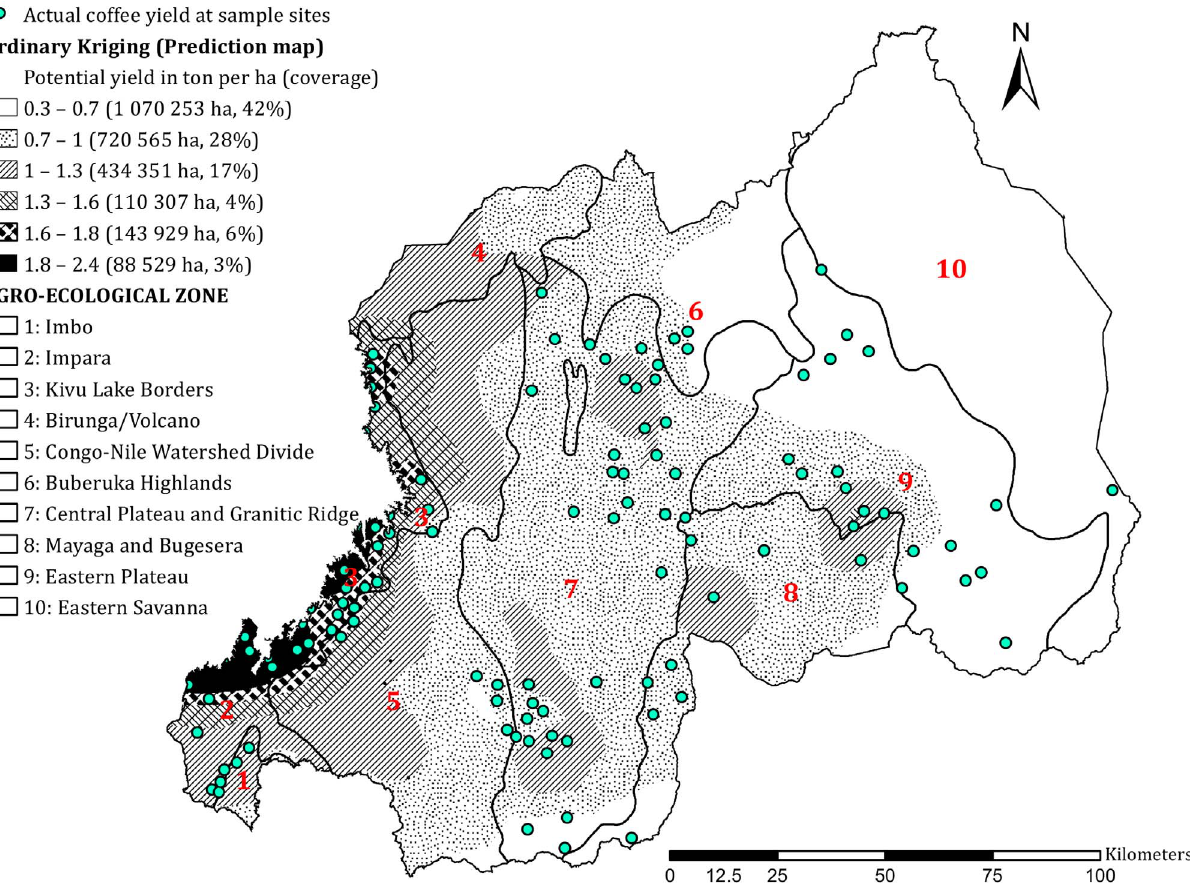
Figure 3. Potential Arabica coffee yield (t ha 2 1 ) predicted using ordinary kriging in the ten agro-ecological zones based on actual yields (t ha 2 1 ) measured at sample sites.